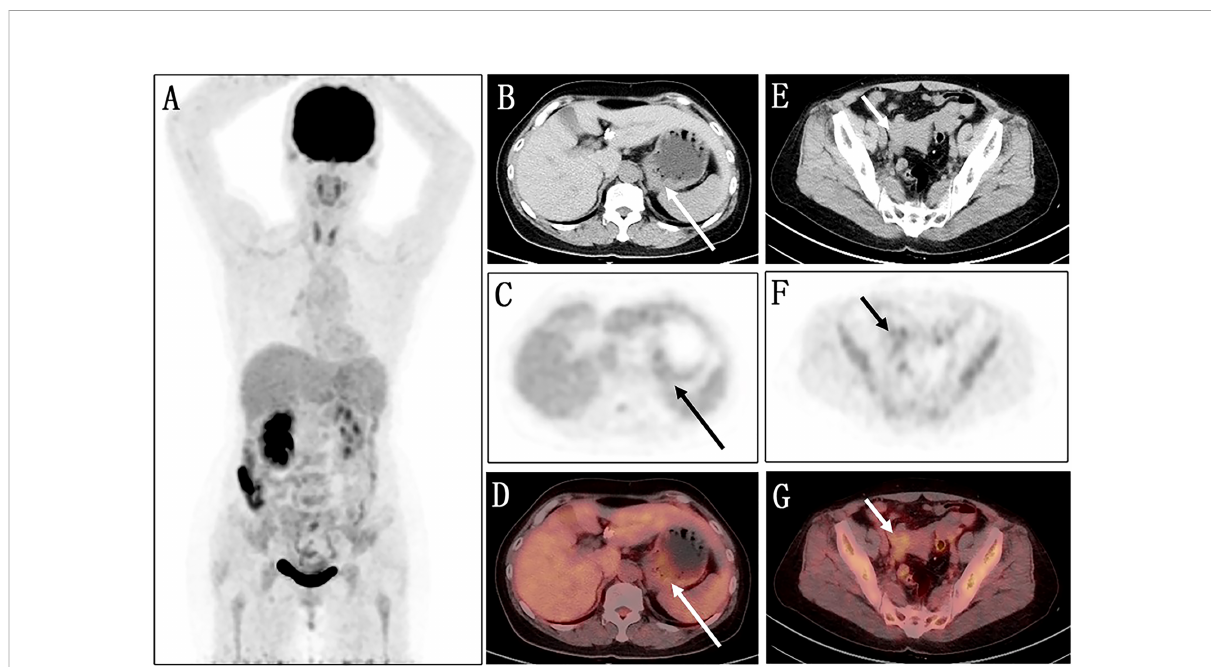
FIGURE 1 Images of 18 F-FDG PET/CT. (A) No obvious abnormality is found in the maximum intensity projection (MIP) image. (B – D) The axial images of the abdominal cavity reveal slight FDG activity in the thickened gastric wall (long arrows; SUV max 3.8). (E – G) Similarly, the axial images of the pelvic cavity show an abnormal mass with a slight FDG uptake in the right adnexal area (short arrows; SUV max